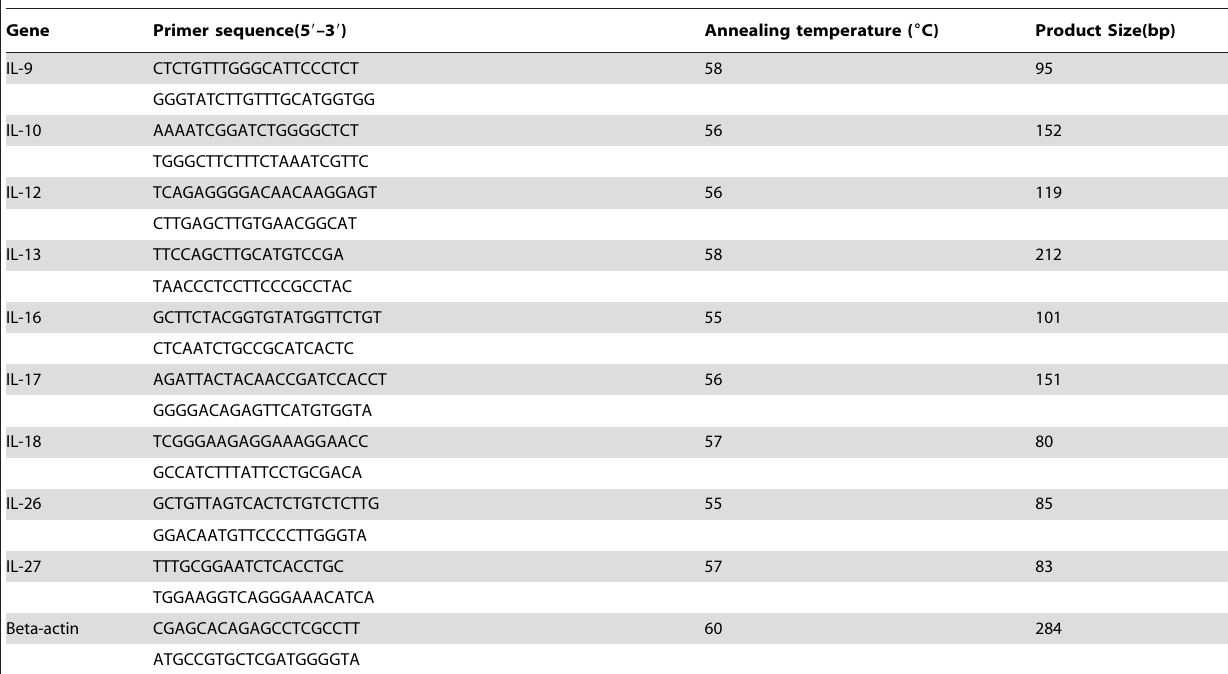
Table 2. Primer sequences used for quantitative real-time RT-PCR.